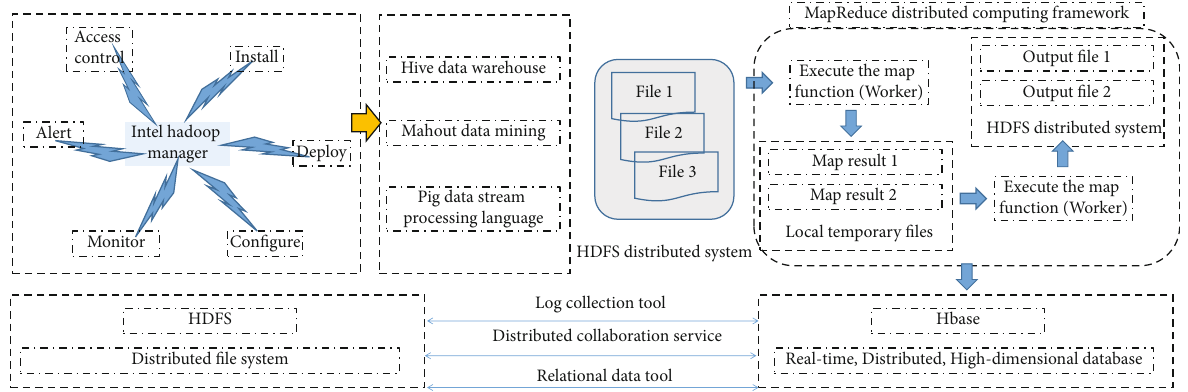
Figure 1: Hadoop structural framework. Table 1: Data cleaning task